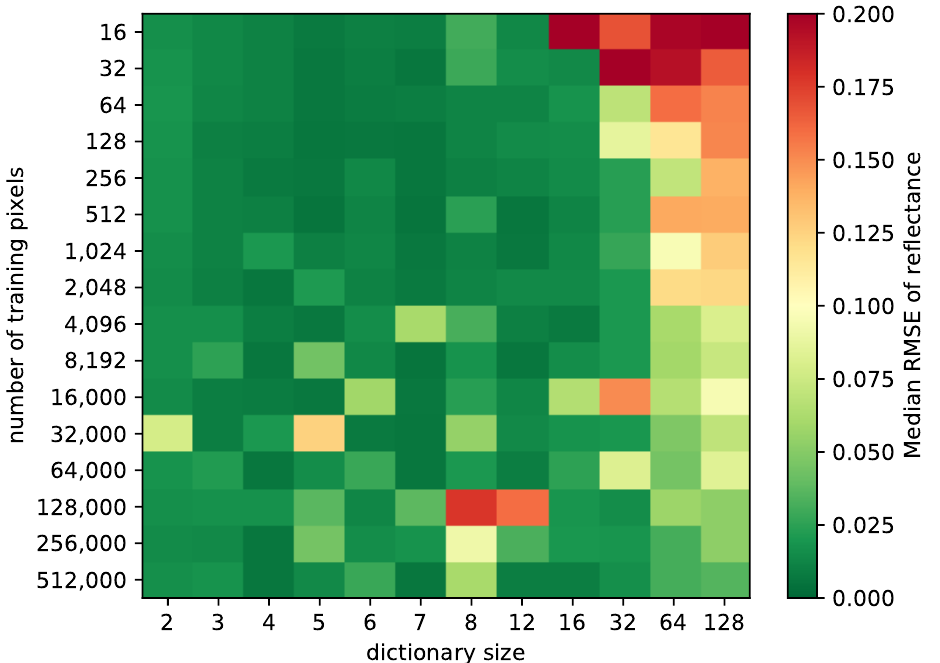
Figure 3. Impact of different dictionary sizes and sizes of the training data on reconstruction